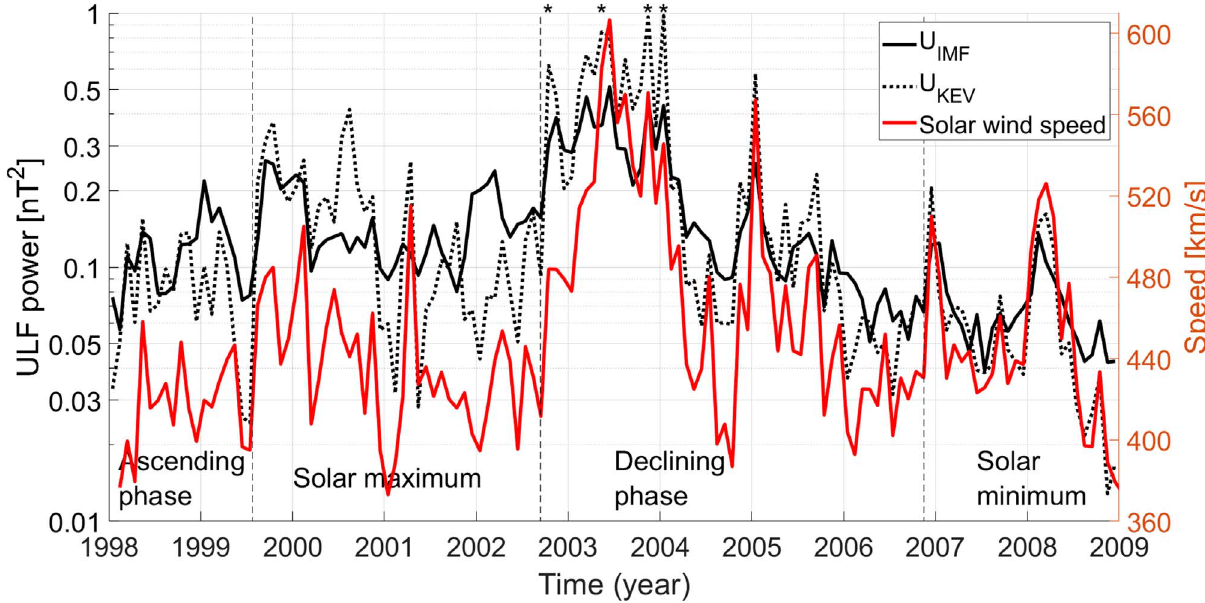
Fig. 1. On the left axis: mean monthly ULF power in the frequency range 2 – 7 mHz in IMF B Z ; mean monthly ULF power on the ground at KEV in the magnetic fi eld component B H , with KEV power down-scaled by a factor of 250. On the right axis: mean monthly solar wind speed. Asterisks imply the four maximum times on the ground. The correlation between IMF and ground ULF wave power is 0.83 for the entire time span studied, 0.31 for the solar maximum, and 0.92 from that onward, i.e. for the declining phase and solar